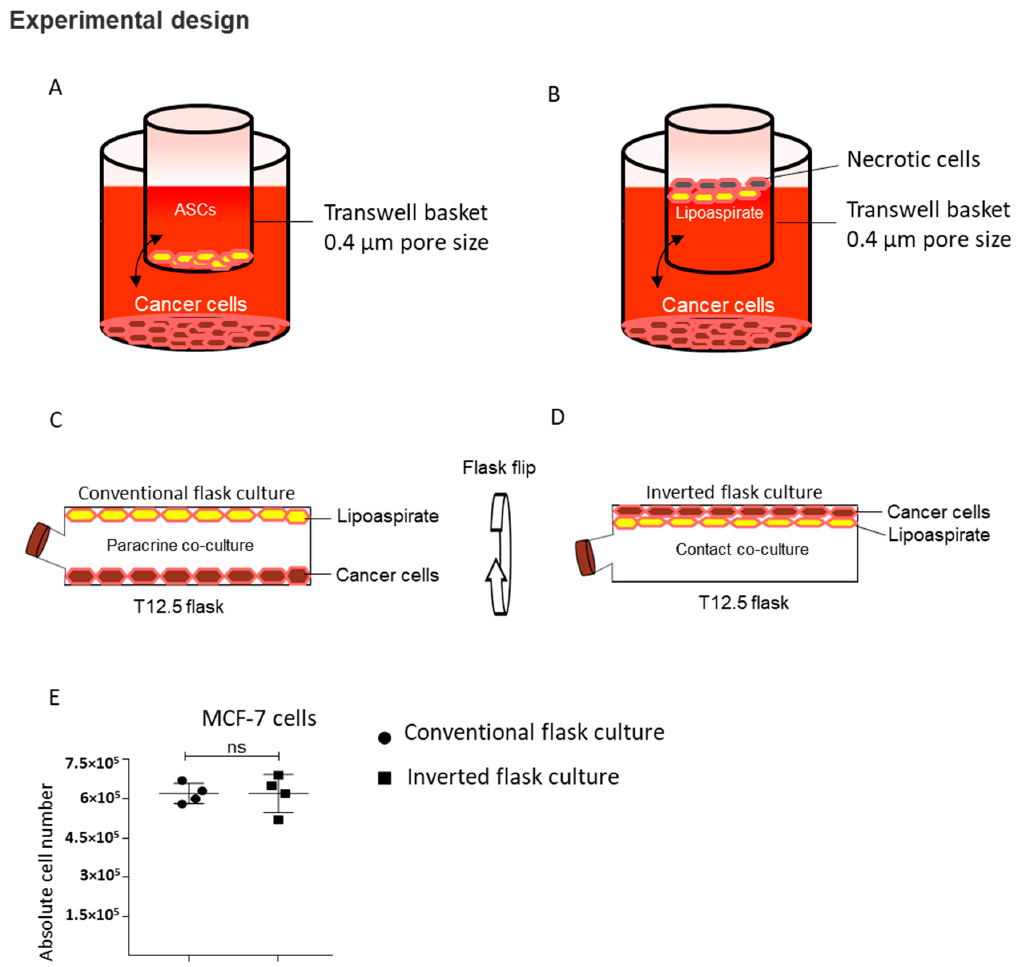
Figure 1. Contact and paracrine co-culture experimental design. ( A ) Paracrine culture setup of cancer cells with adipose-derived stem cells (ASCs) using 6-well transwell plates. ( B ) Paracrine culture setup of cancer cells with lipoaspirates. ( C , D ) Modified paracrine ( C ) and contact ( D ) co-culture of cancer cells with lipoaspirate using T12.5 cm 2 flask. ( E ) Comparison of MCF-7 cells proliferation in conventional and inverted flask culture ( n = 4). ns = non-significant.